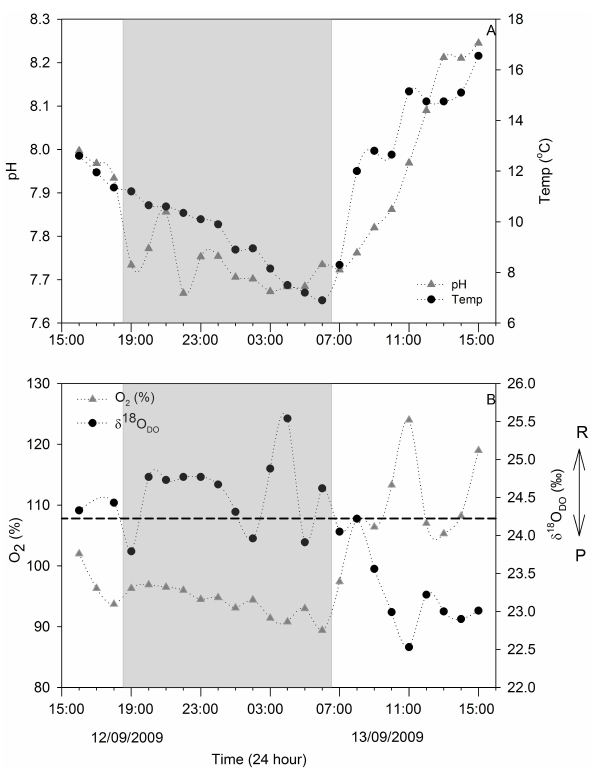
Fig. 10. Diurnal fluctuations of (A) pH and temperature, and (B) δ 18 O-DO and % saturation of dissolved oxygen at Chania Stream. Night-time is indicated in